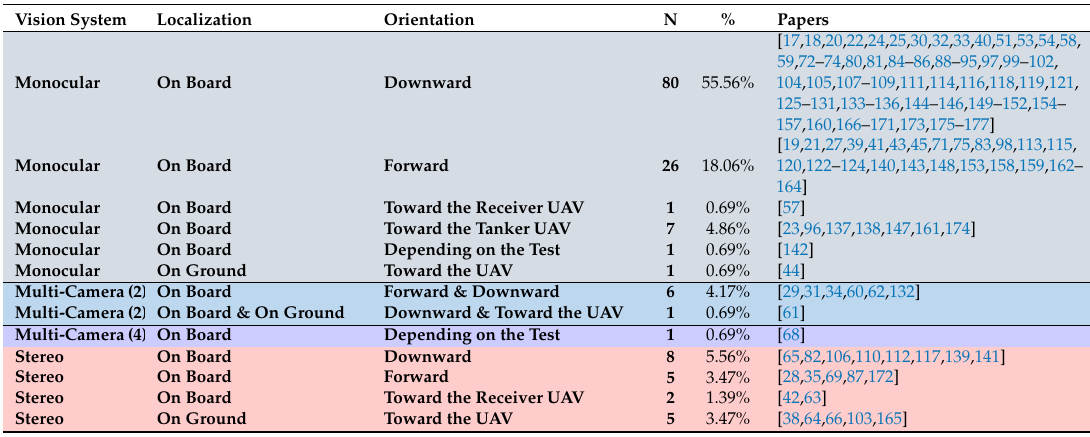
Table 6. List of papers per vision system.